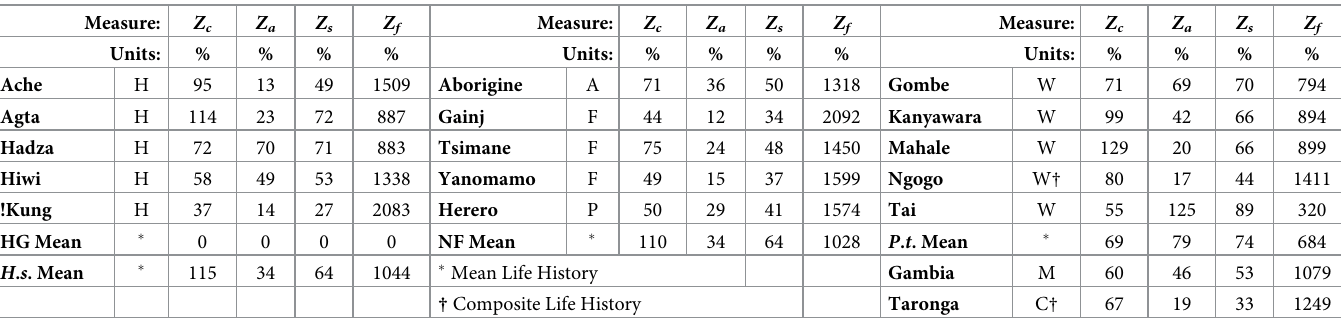
Ratios ( Z = C / E ) of realized retrospective fitness contributions to the potential reflected in prospective elasticities for child survival ( Z c ), adult survival ( Z a ), all survival ( Z ) and fertility ( Z ). Separated rows show results for the mean life histories of hunter-gatherers (HG Mean, the LTRE reference), non-foragers (NF Mean), human s f small-scale societies ( Homo sapiens , H . s . Mean), and wild chimpanzees ( Pan troglodytes , P . t . Mean). Human subsistence modes in the second column are abbreviated: H (hunter-gatherer), A (acculturated hunter-gatherer), F (forager-horticulturalist) or P (pastoralist); chimpanzee management status is abbreviated: W (wild), M (managed) or C (captive).